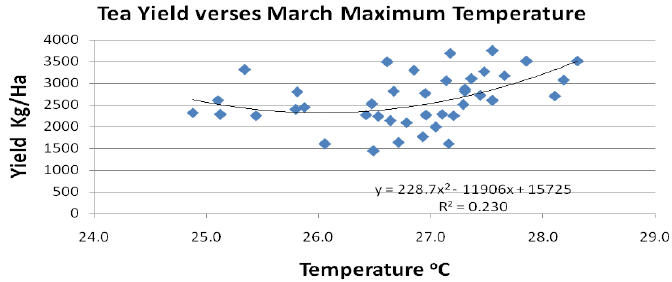
Figure 2. The scatter diagram showing the relationship between March maximum temperatures and the tea yield.